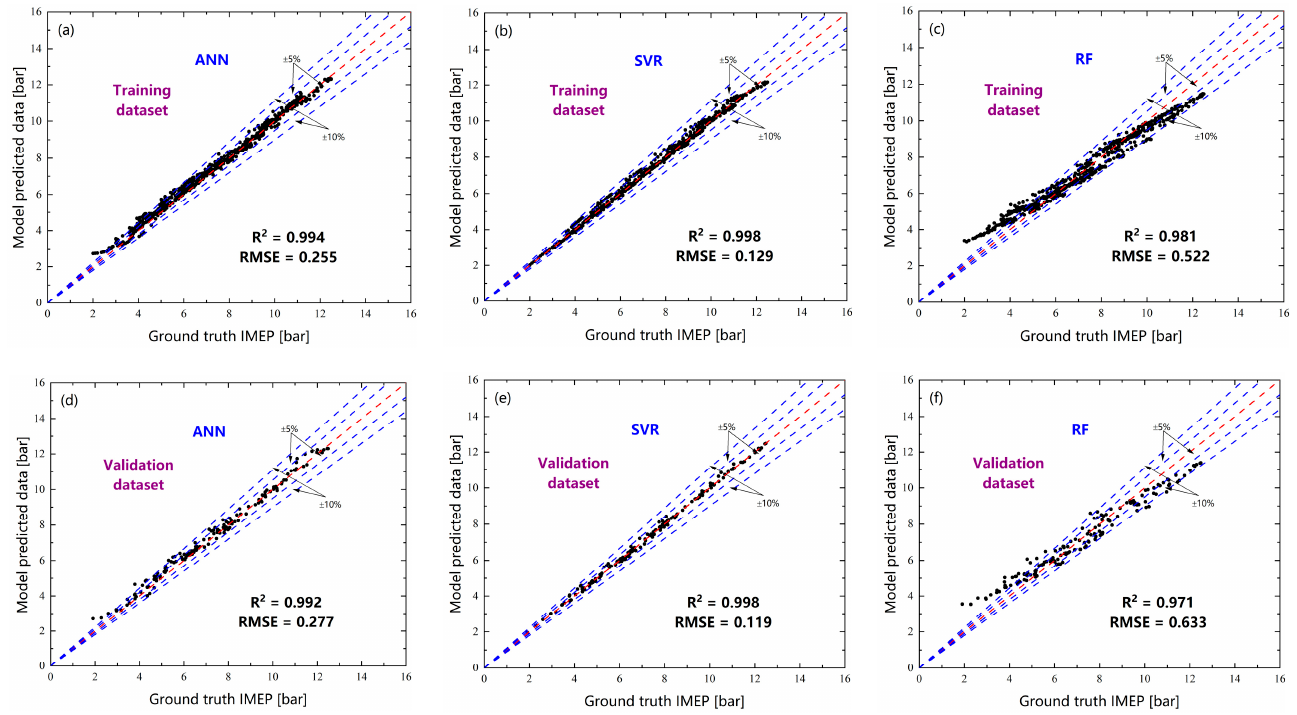
Figure 5. Comparison of predicted IMEP with actual values based on different ML models: ( a ) ANN predicted performance for the training dataset; ( b ) SVR predicted performance for the training dataset; ( c ) RF predicted performance for the training dataset; ( d ) ANN predicted performance for the validation dataset; ( e ) SVR predicted performance for the validation dataset; ( f ) RF predicted performance for the validation dataset.